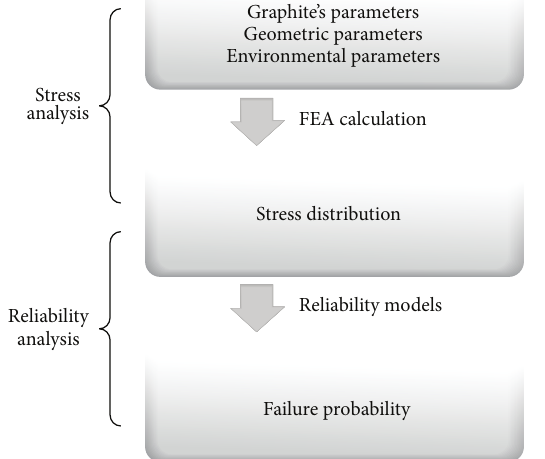
Figure 1: Mechanical analysis procedures of graphite